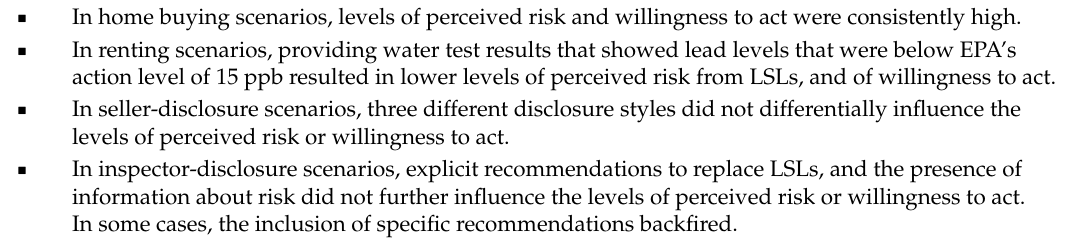
Table Note: “Why” refers to conditions where additional information about why to replace an LSL was provided. “Rec” refers to conditions where explicit recommendations about strategies to ensure the removal of the LSL before moving into the home were provided. See Table 4 for the exact wording of the willingness to adopt risk mitigation behavior items. Unless otherwise indicated, all the variables were measured on a 1–6 scale. Conditions with the same letter (i.e., a , b , c , d , e , f ) in the same row are statistically different at p < 0.05 (One-way ANOVA results with Bonferroni corrections; the result for “click on the link” was based on a logistic regression). M: mean; SD: standard deviation.